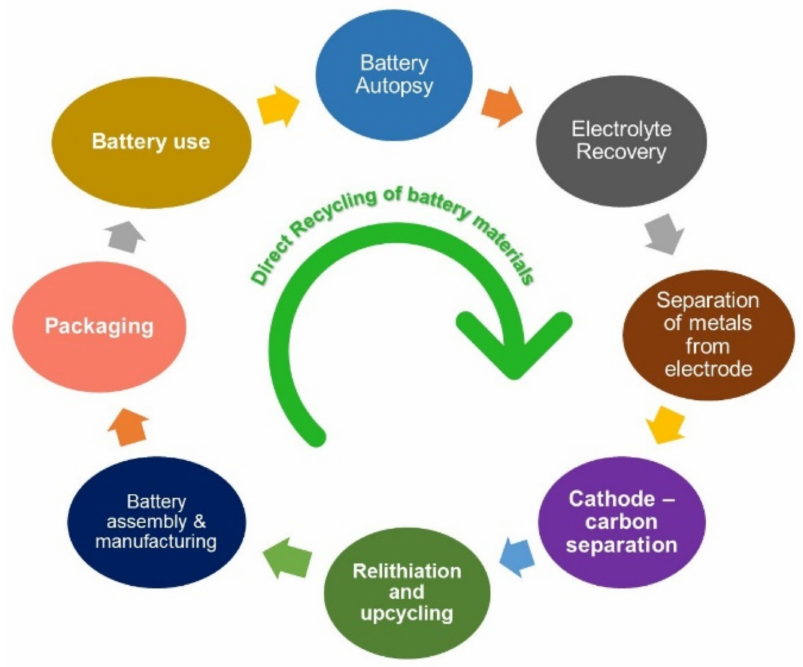
Figure 32. Direct and simple battery recycling flow